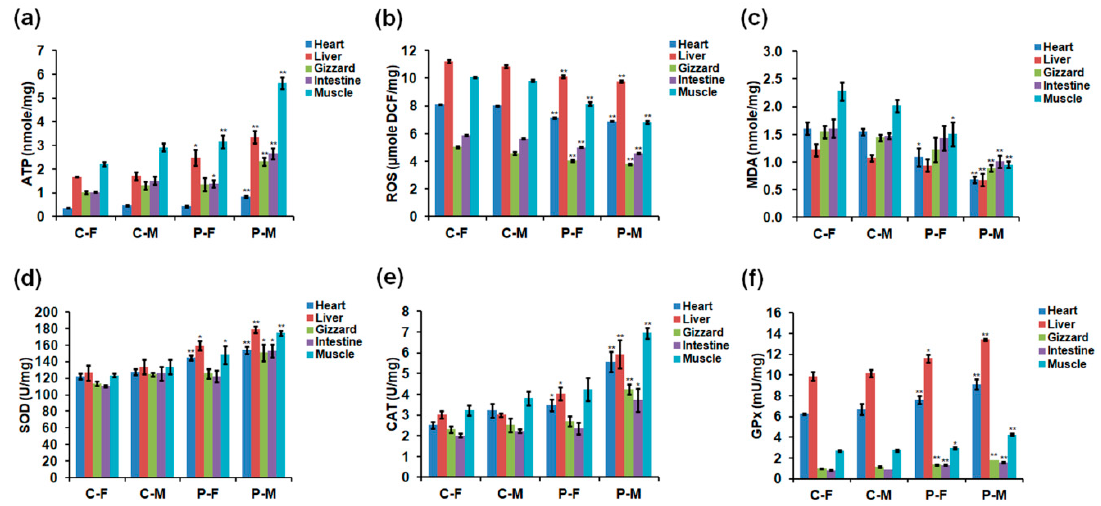
Figure 4. Concentrations of ( a ) ATP, ( b ) ROS, ( c ) MDA, ( d ) SOD, ( e ) CAT, and ( f ) GPx in different organs of 90-day-old chickens. Data are presented as mean ± SD ( n = 10) of three replicates; n represents an individual chicken. *, p < 0.05 versus control; **, p < 0.01 versus control in females and males, respectively, according to the one-way ANOVA with an LSD test.